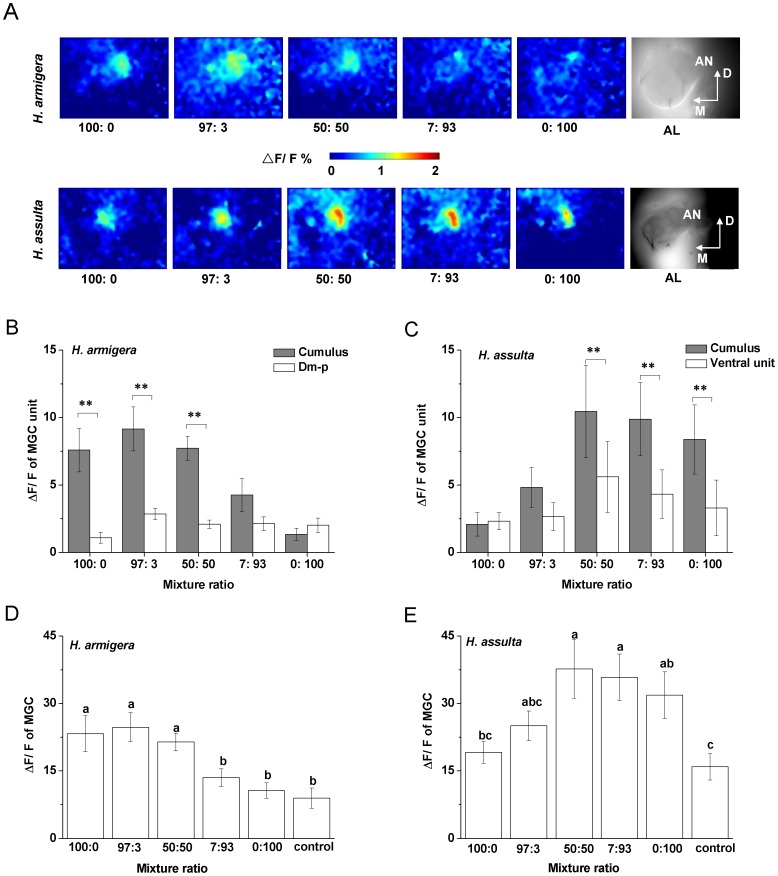
Glomerular activities in antennal lobes induced by binary pheromone mixtures at different ratios.MGC, macroglomerular complex. Ratios of the two compounds are Z11–16: Ald to Z9–16: Ald. 10 µg was used as stimulus dose. A, peak activities to different binary mixtures in false-color scale in H. armigera and H. assulta. For each species, all the pictures were taken on the same optical plane and had the same size (320×240 pixels); the last picture of the row shows the AL structure. D, dorsal; M, medial. B and C, net responses of MGC units to binary mixtures at different ratios in H. armigera and H. assulta. Values are mean ± SEM. (Paired t-test, ** P<0.01, H. armigera, n = 6; H. assulta, n = 6). D and E, response intensity of whole MGC to binary mixtures at different ratios in H. armigera and H. assulta, respectively. Values are mean ± SEM. The same letters above bars are not significantly different from one another (ANOVA, P<0.05, H. armigera, n = 6; H. assulta, n = 6).